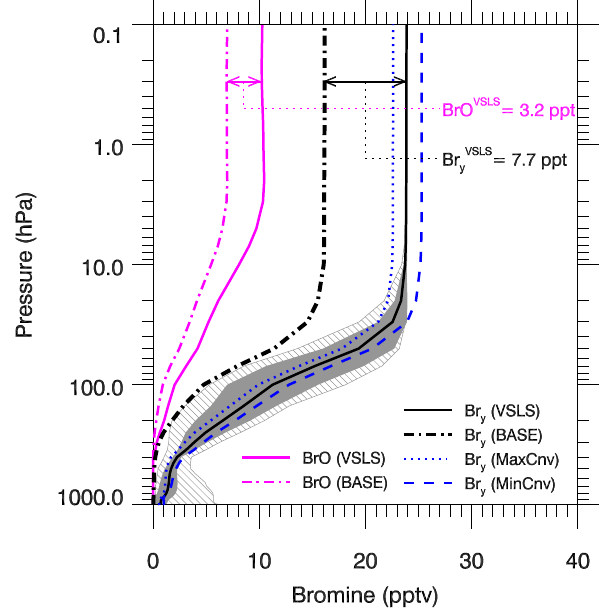
Figure 3. Model simulated global and annual mean BrO and Br y profiles from the simulation with VSLS ( R VSLS , solid lines) and the base simulation without VSLS ( R BASE , dash-dotted lines) for the year 2010. The gray shading indicates the spread of annual mean Br y in the R VSLS run with the hatched areas indicating the minimum to maximum range and the solid shadings indicating one sigma variance. Br y from the two convective sensitivity simulations is also shown (blue dashed and dotted line for minimum and maxi- mum convection conditions,